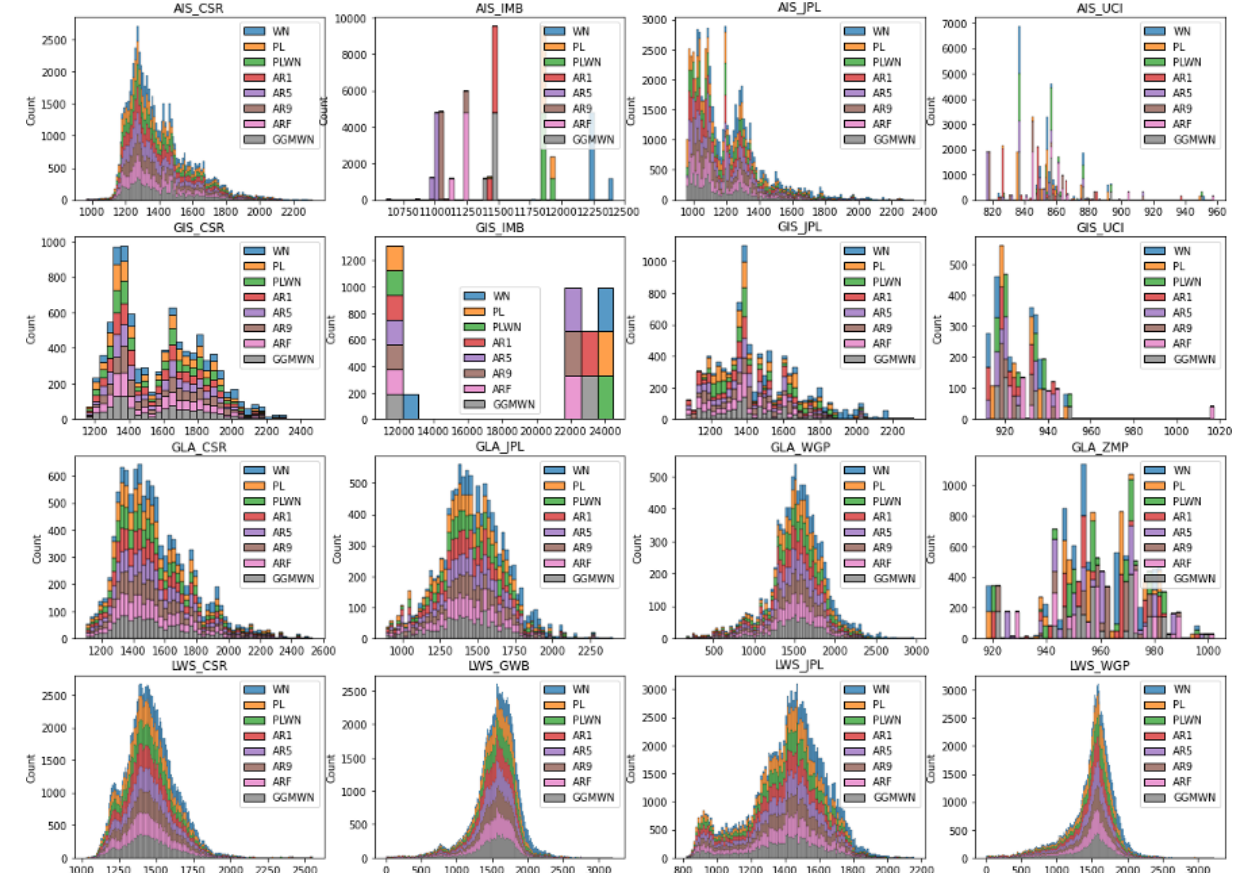
Figure B2. Histogram of the modified Bayesian information criterion for each dataset, used to select the optimal noise models. The x axis shows the BIC score and the y axis the number of grid points (count). Note that all models have scores within the same range, showing that no model fails in capturing the signal of the observation.